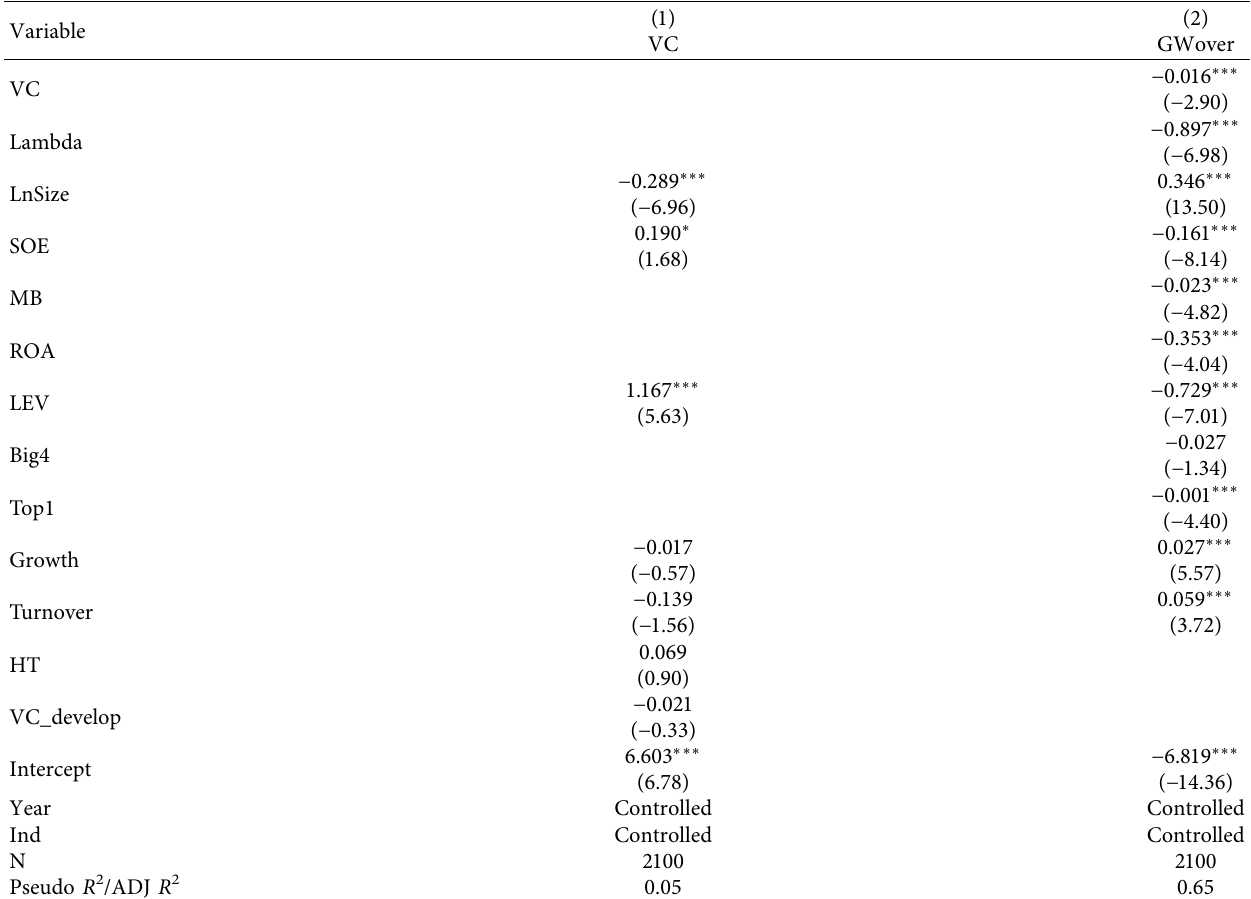
Table 5: Heckman two-stage regression.